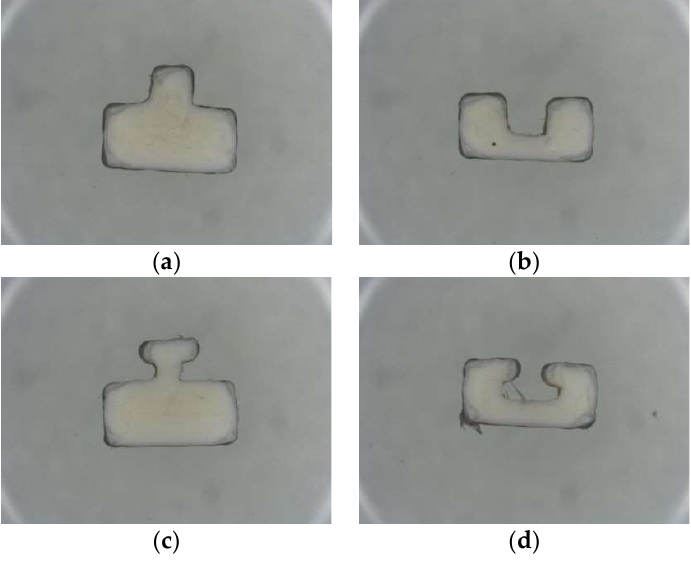
Figure 4. Cross sections of FDM inserts : ( a ) MC 50, ( b ) FC 50, ( c ) MT 50, and ( d ) FT 50.